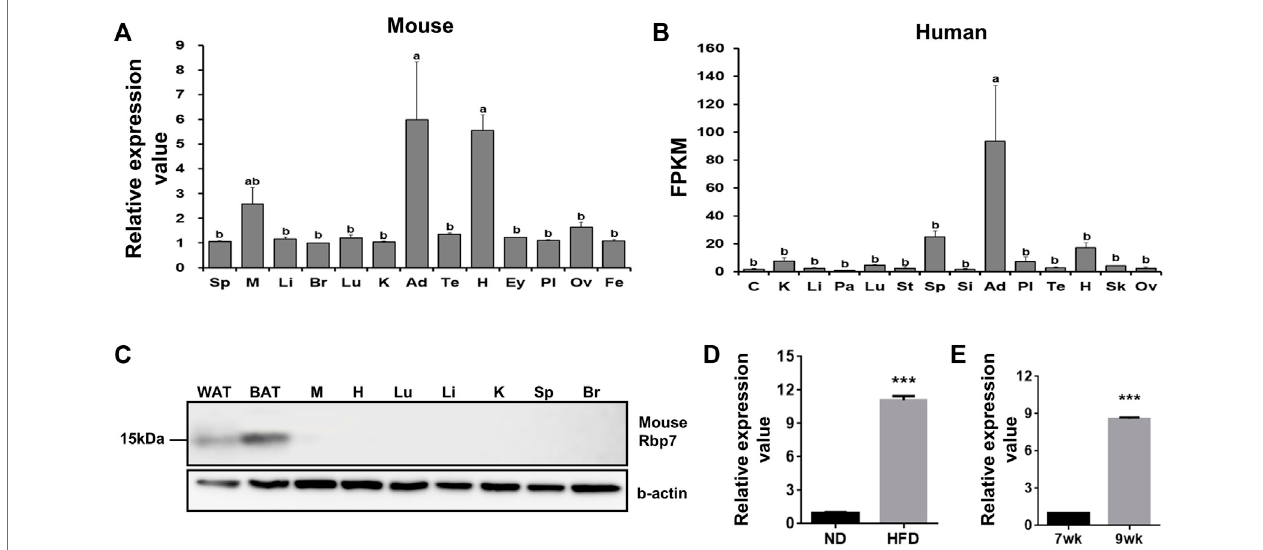
FIGURE 1 | Tissue distribution of Rbp7 expression. (A,B) Expression levels of mouse and human RBP7 in various tissues were presented based on microarray (GEO dataset) and RNA-seq dataset (Human Protein Atlas). (C) Western blot analysis was conducted to detect mouse RBP7 protein in various tissues. Sp: spleen, M: muscle, Li: liver, Br: brain, Lu: lung, K: kidney, Ad: adipose tissue, Te: testis, H: heart, Ey: eye, Pl: placenta, Ov: ovary, Fe: fetus, C: colon, Pa: pancreas, St: stomach, Si: smallintestine,Sk:skin,WAT:whiteadiposetissue,BAT:brownadiposetissue. β -actinwasusedasaloadingcontrolforanequalamountofproteinextracts.One- way ANOVA followed by Tukey ’ s multiple comparisons test was used and the bars indicate means ± S.E.M. statistically signi fi cant differences are marked by the three letters, a, ab, or b ( p < 0.05). (D) Expression levels of mouse Rbp7 in epididymal adipose tissues after feeding high-fat diet for 2 weeks. (E) Age-related changes in expression levels of Rbp7 in mouse epididymal adipose tissues. The expression data in D and E were presented based on GEO dataset. t -tests were used for statistical analysis by the Graphpad PRISM 6.02 program. The bars indicate means ± S.E.M. *** p <